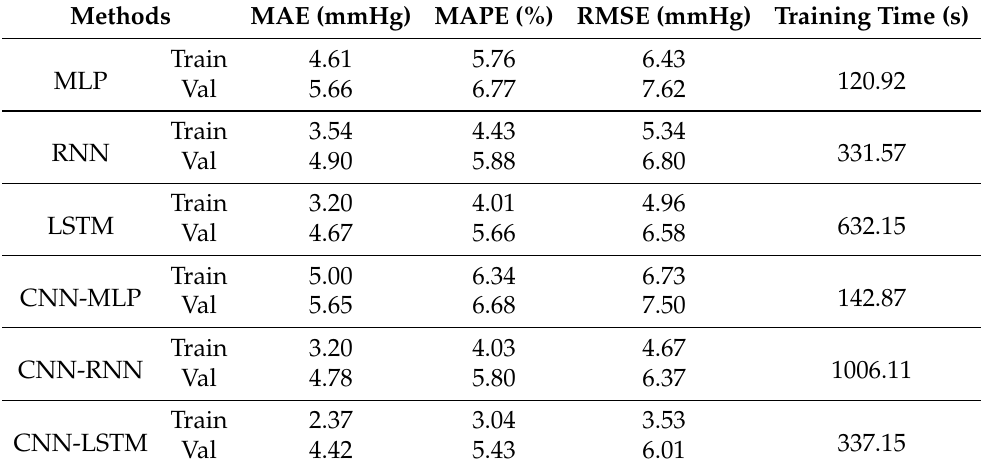
Table 3. Average predicted performance of